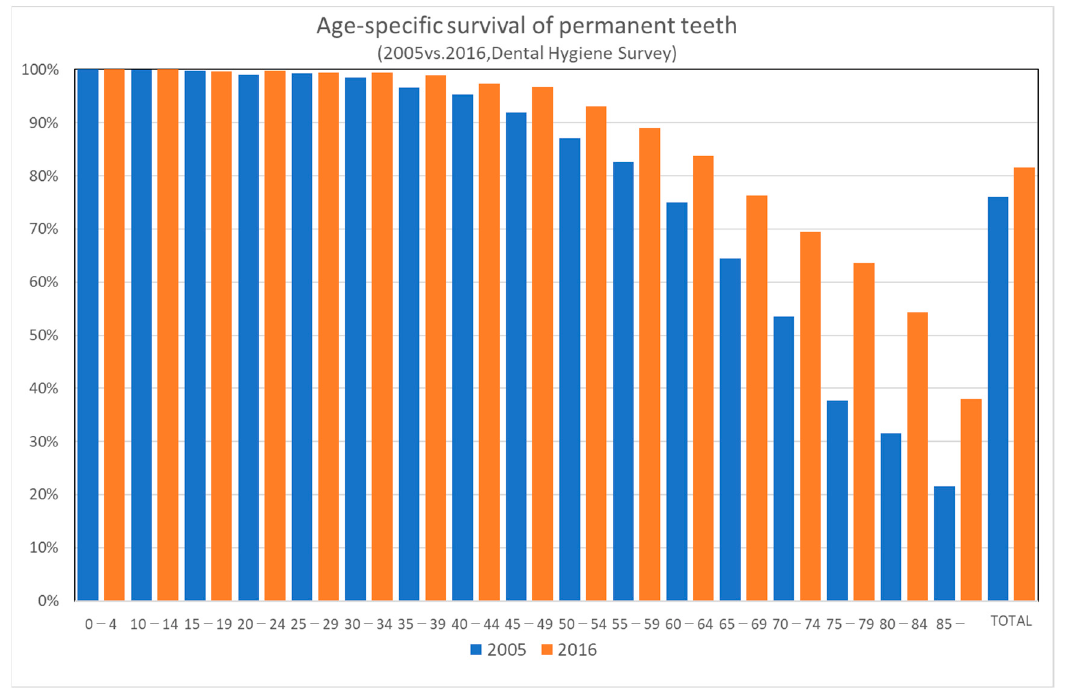
Figure 1. Age-specific survival of permanent teeth.